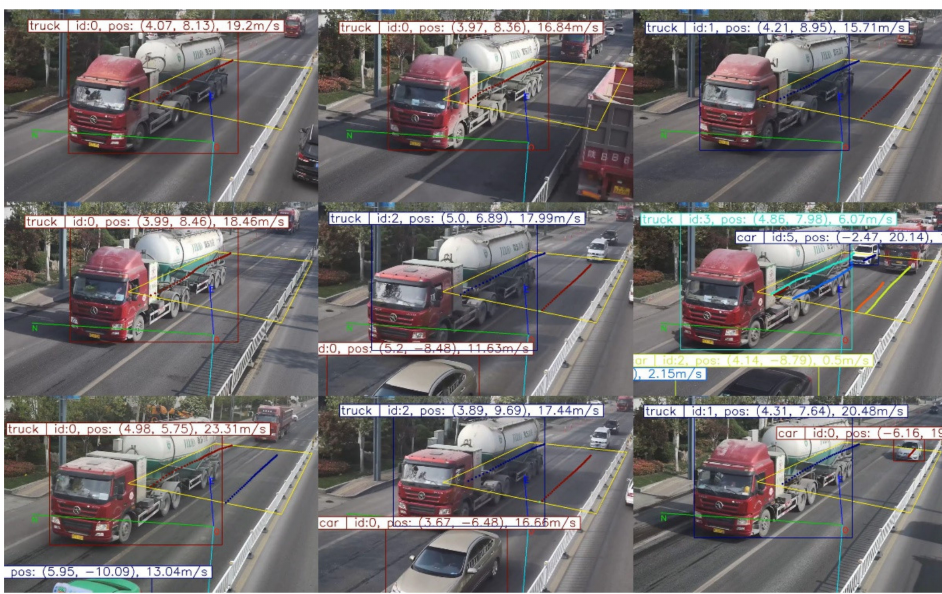
Figure 10. Extraction effect of driving status information of some trucks.